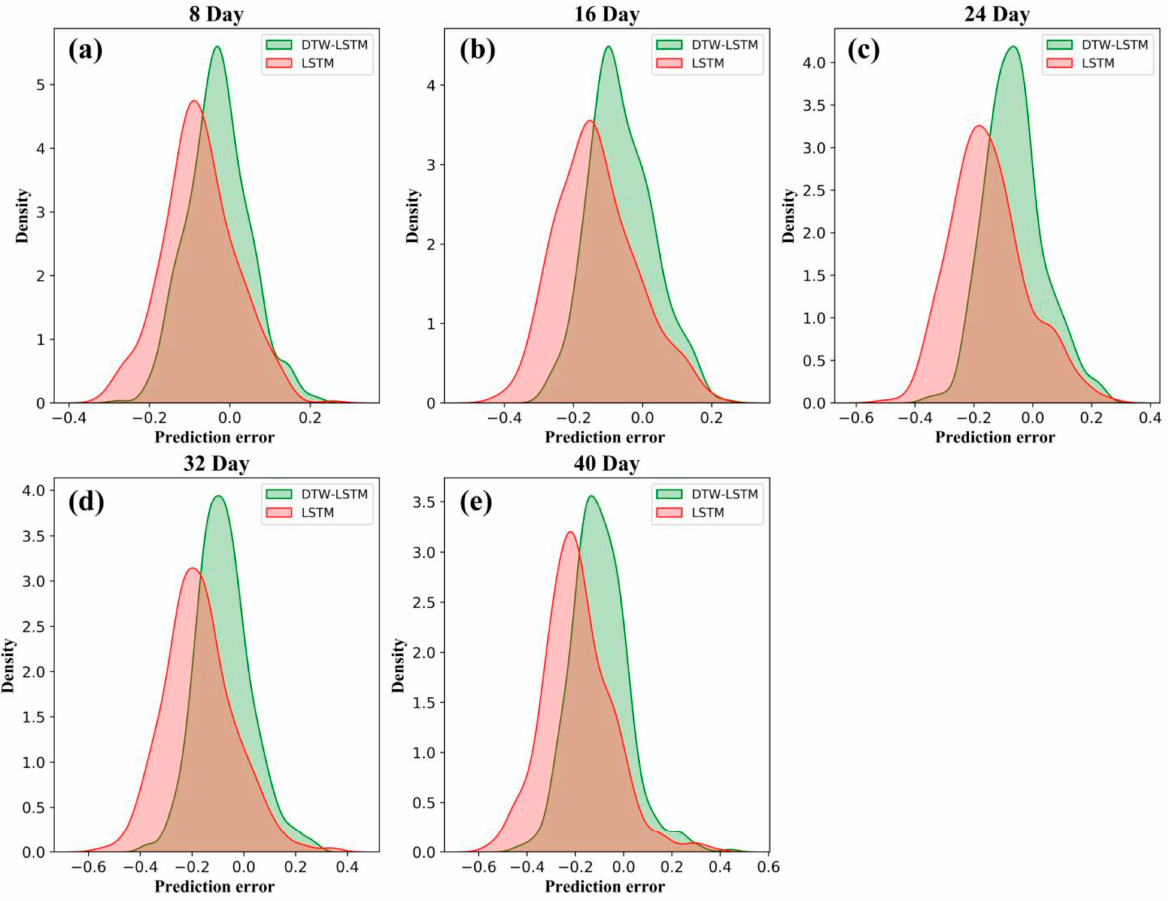
Figure 11. Gaussian kernel density estimation of prediction errors using the DTW–LSTM and LSTM methods for different prediction horizons. ( a ) 8 days, ( b ) 16 days, ( c ) 24 days, ( d ) 32 days, ( e ) 40 days.